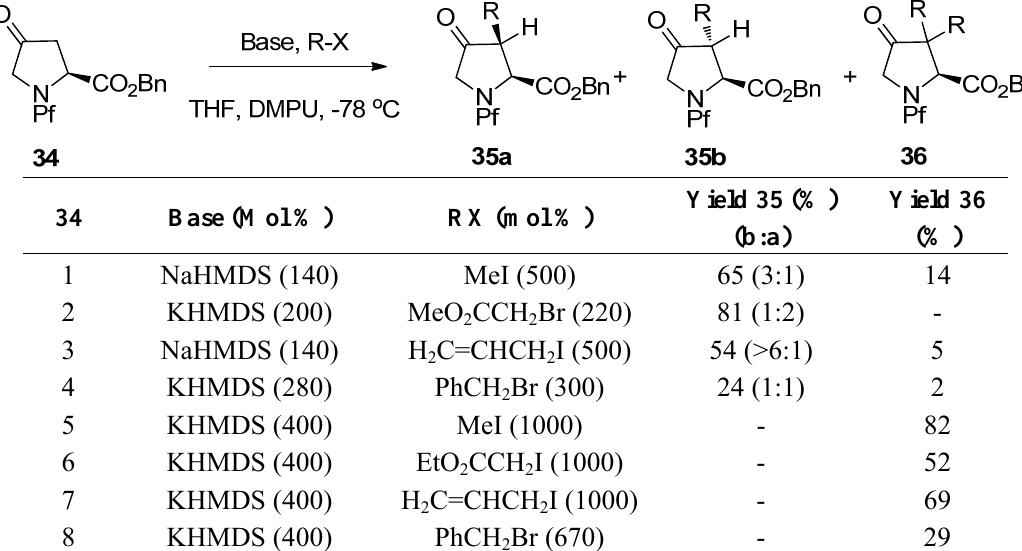
Table 5. Alkylation of N -Pf-proline ketone and its stereoselectivity